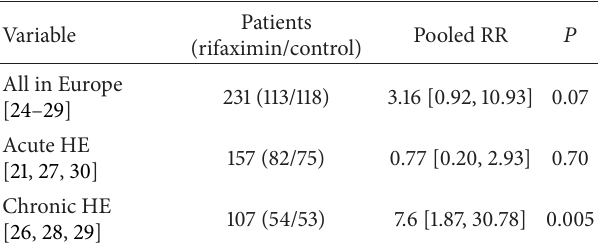
Table 4: Result of sensitivity